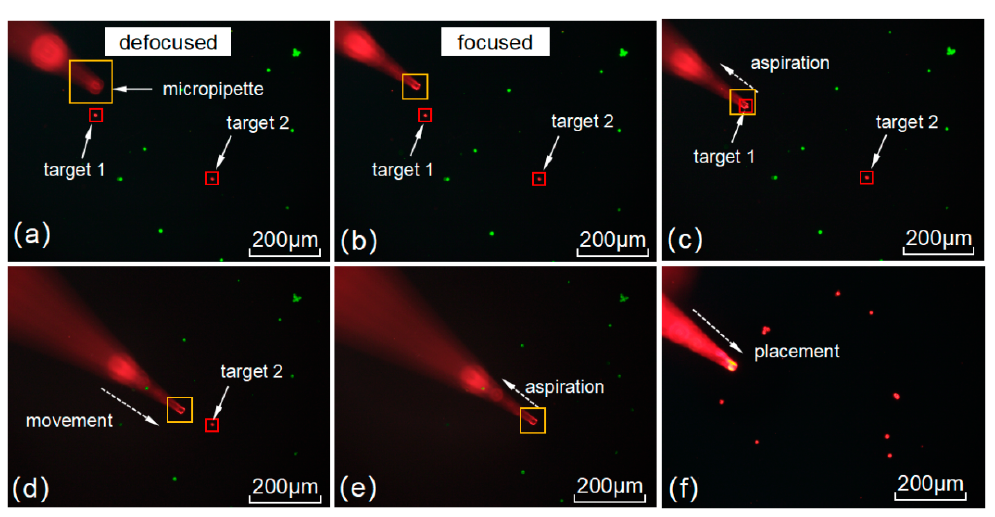
Figure 14. Automated fast autofocusing visual feedback (FAVF) cell sorting. Micromachines 2019 , 10, x